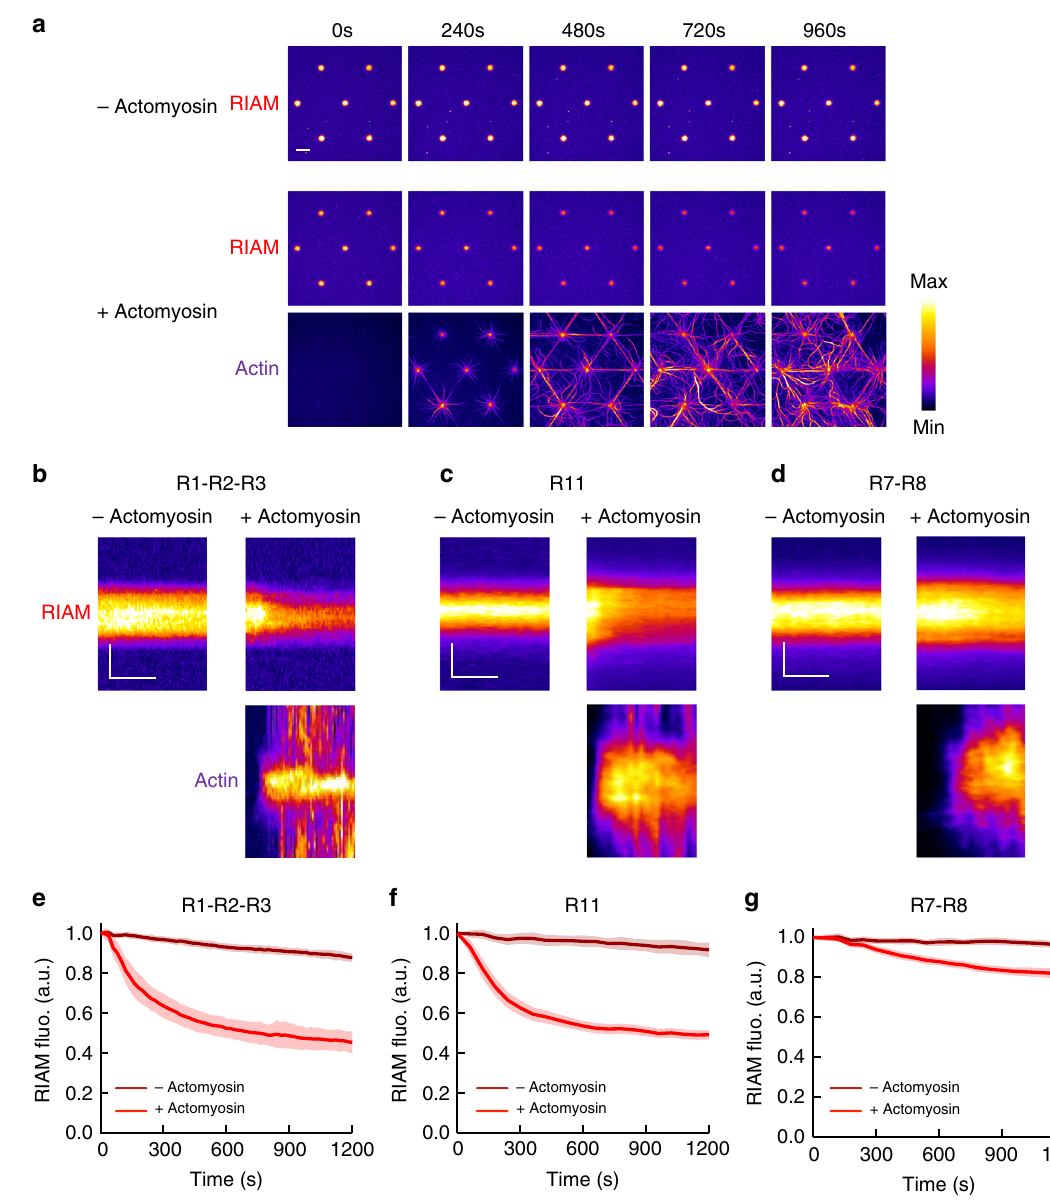
Fig. 3 The actomyosin force provokes RIAM dissociation from several talin domains. a Time lapses showing the binding of RIAM 1-306 to talin R1 – R2 – R3-coated disks in the absence (top) or presence of actomyosin (RIAM is shown on the middle and actin on the bottom panel). This experiment was repeated 11 times independently with the same results. b – d Kymographs of mCherry-RIAM 1-306 (top) and actin (bottom) along a cross-section of a disk coated with talin R1 – R2 – R3 ( b ) R11 ( c ) or R7 – R8 ( d ) in the absence (left) or presence (right) of actomyosin. For better comparison, the fl uorescence of mCherry-RIAM 1-306 in kymographs was normalized as the maximal fl uorescence in the R11- and R7 – R8-coated disks. Conditions: 100 nM mCherry-RIAM 1-306, 2.4 µ M actin (1% Alexa647-labeled for R1 – R2 – R3, 2% Alexa488 for R11 and R7 – R8), 50 nM myosin, 1 µ M talin during the coating step. The images are color coded using the fi re LUT of ImageJ. Scale bar in time lapses = 10 µ m. In kymographs, horizontal bar = 500 s, vertical bar = 5 µ m. e – g Kinetics of the mean fl uorescence of mCherry-RIAM 1-306 corresponding to the conditions described in ( b – d ). Data are mean ± SD. e n = 63 ( − actomyosin), n = 62 disks ( + actomyosin). f n = 50 ( − actomyosin), n = 60 disks ( + actomyosin). g n = 49 ( − actomyosin), n = 60 disks ( + actomyosin). Data were fi rst normalized to 1 as the maximal mCherry-RIAM 1-306 fl uorescence and synchronized using this maximal value as t 0 before being averaged. Source data are provided as a Source data fi le. See Supplementary Movie 4, Supplementary Movie 5, and Supplementary Movie